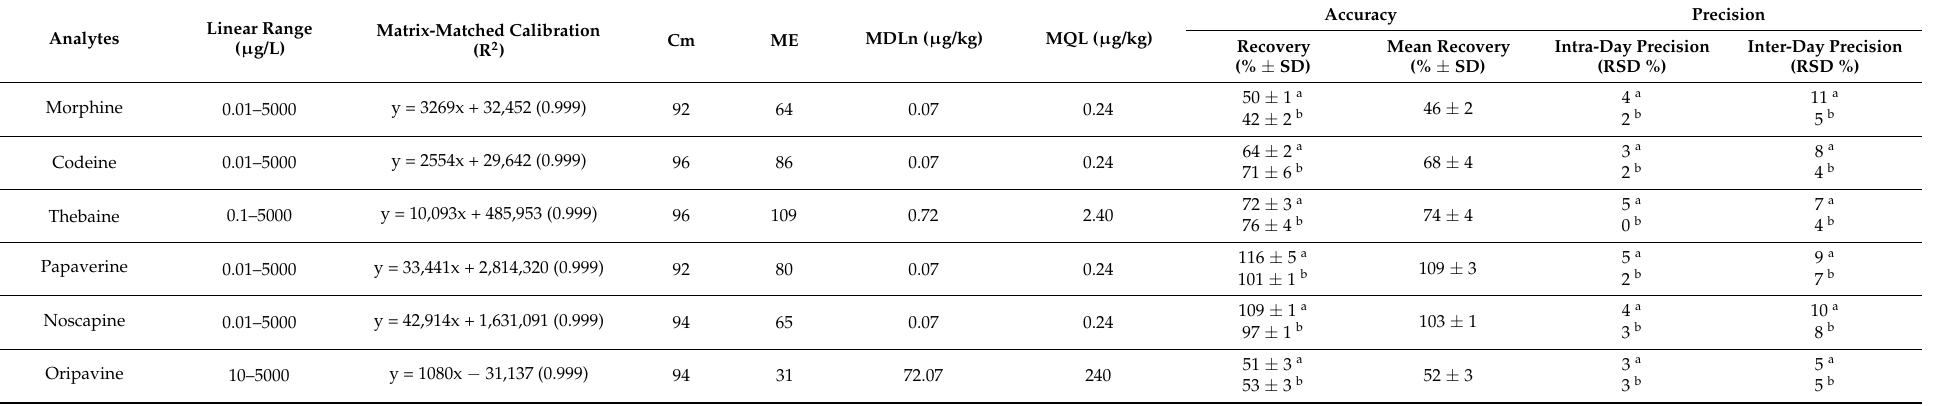
Table 2. Validation parameters of the SLE-MSPE-UHPLC-QqQ-MS/MS method for the determination of six opium alkaloids in poppy seeds